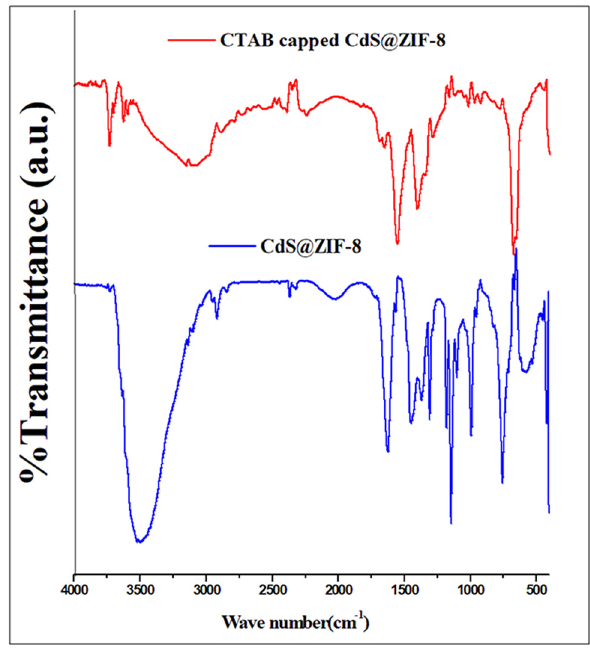
Figure 1: FTIR spectra of CdS@ZIF - 8 and CTAB - capped